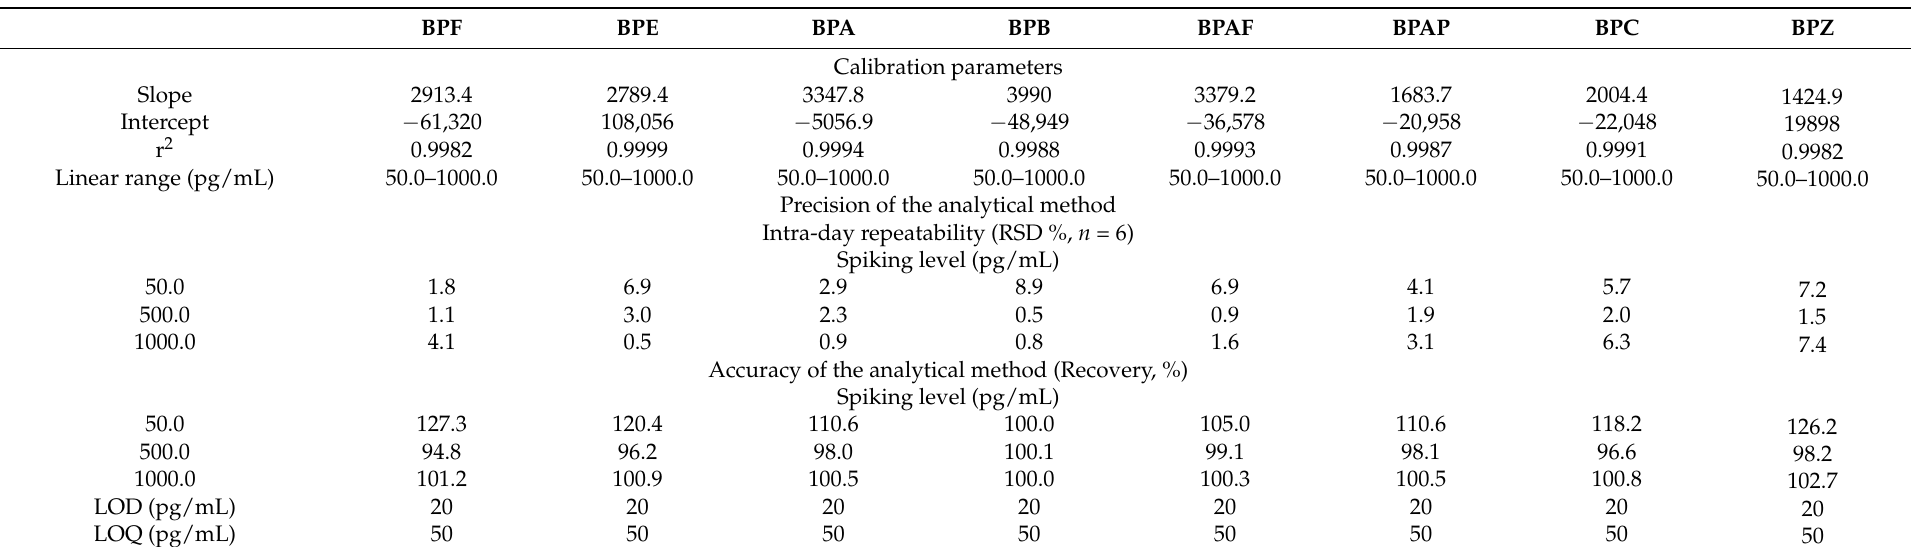
Table 2. The linearity, repeatability, recoveries, LODs and LOQs for eight